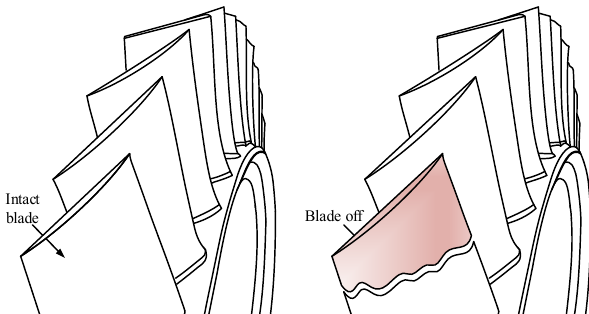
Figure 2. Schematic diagram of a blade off event.